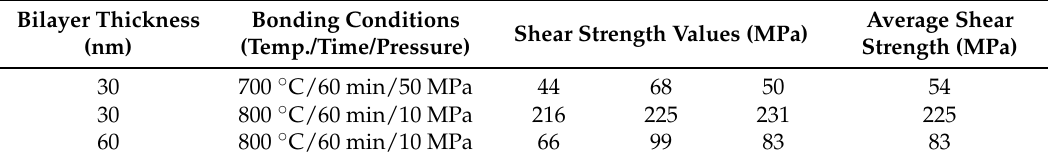
Figure 6. ( a ) Hardness and ( b ) reduced Young’s modulus distribution maps of the joint produced at 800 °C using a Ni/Ti multilayer with 30 nm of bilayer thickness. Table 1. Shear strength values of TiAl/steel joints produced using Ni/Ti multilayers. Table 1. Shear strength values of TiAl/steel joints produced using Ni/Ti